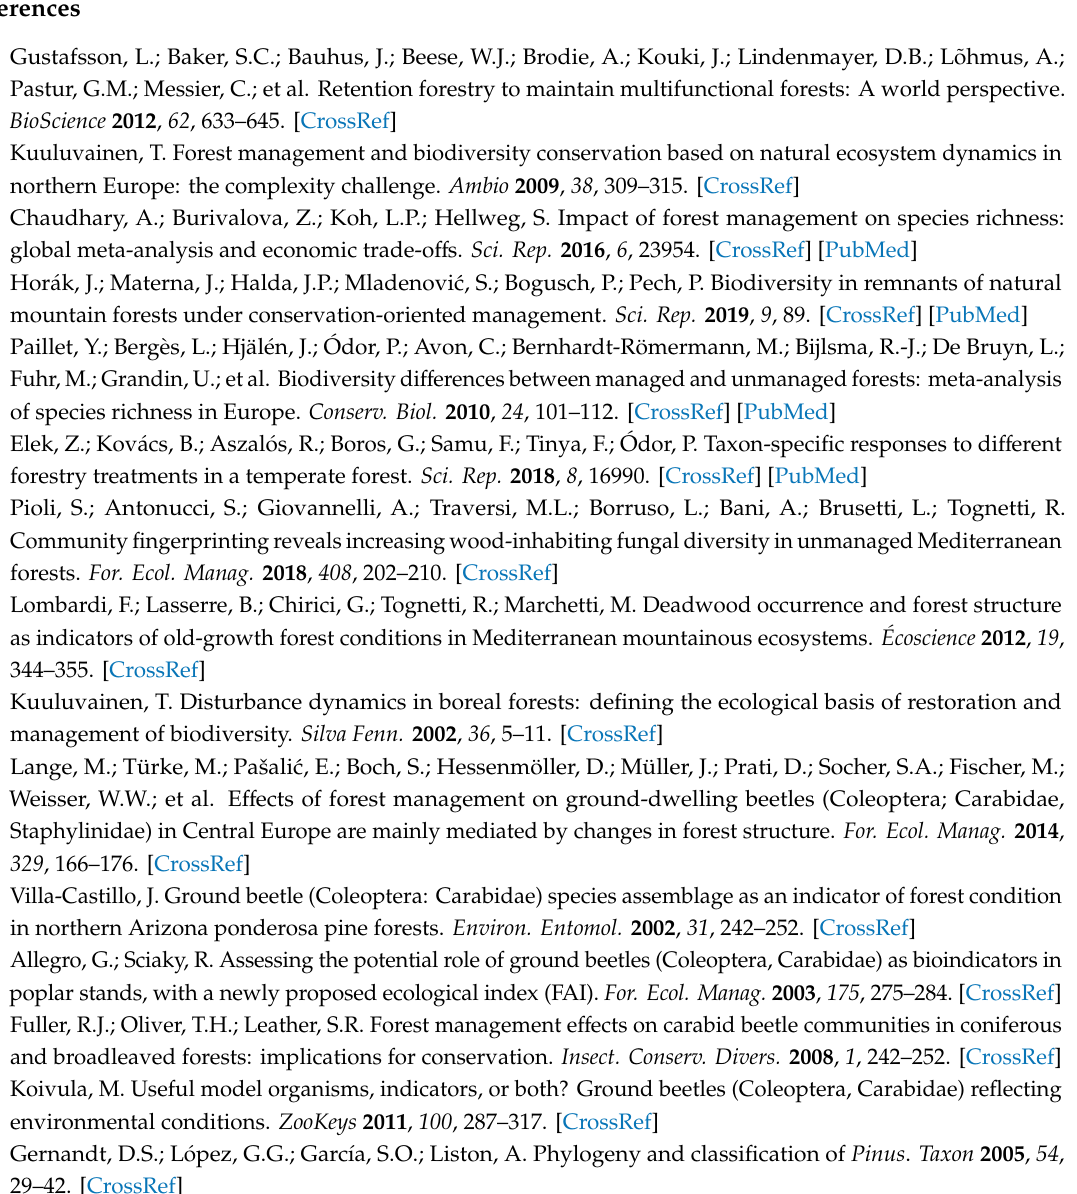
Table S1: Relative abundance of fungal taxa sequenced from needles and soil of Pinus sylvestris from managed and unmanaged forest stands in